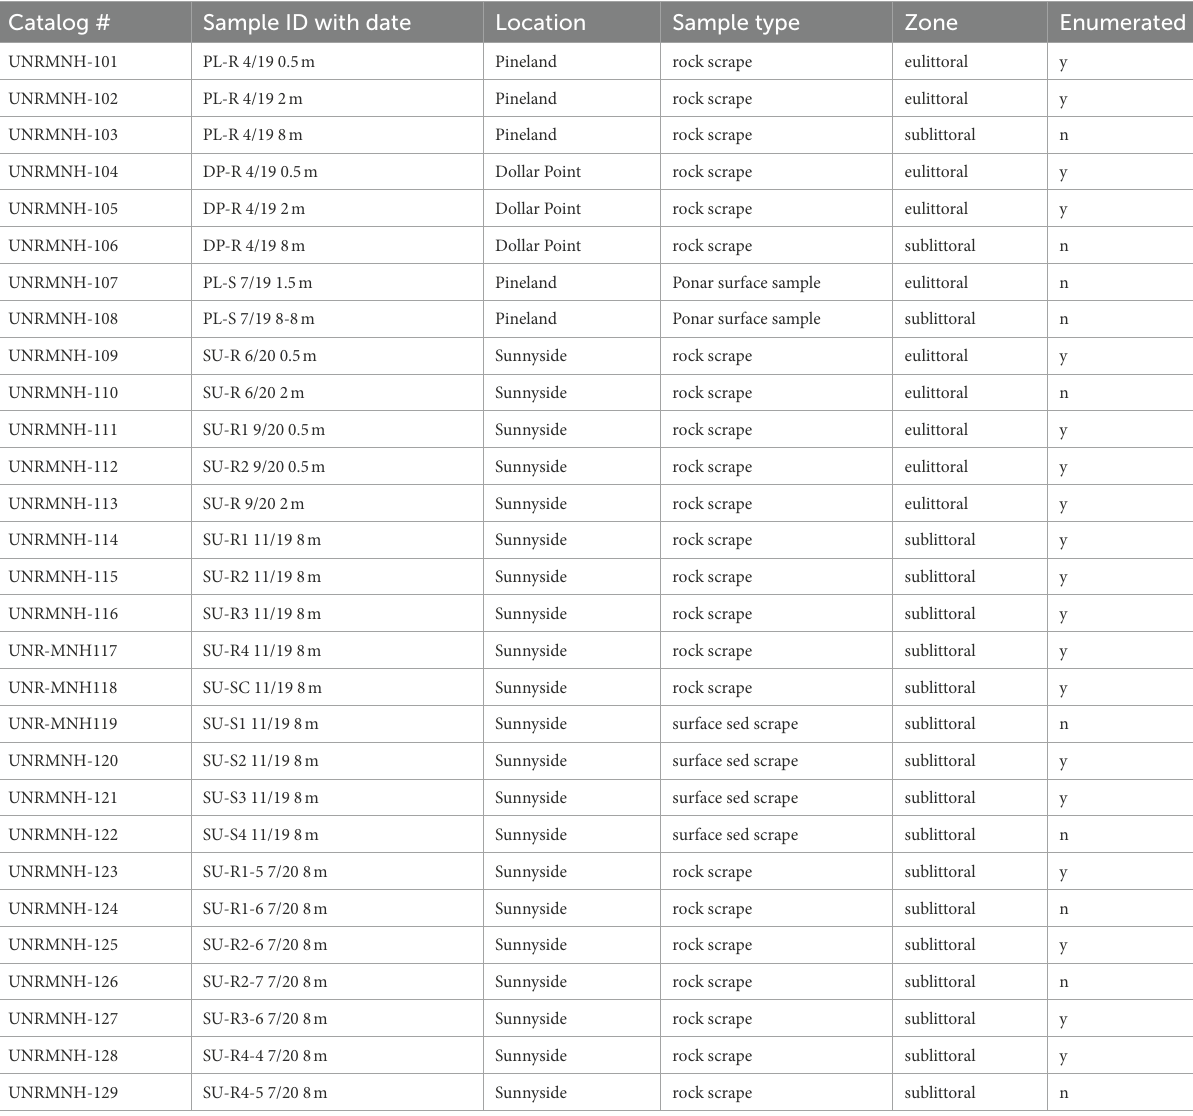
TABLE 1 List of samples taken for diatom